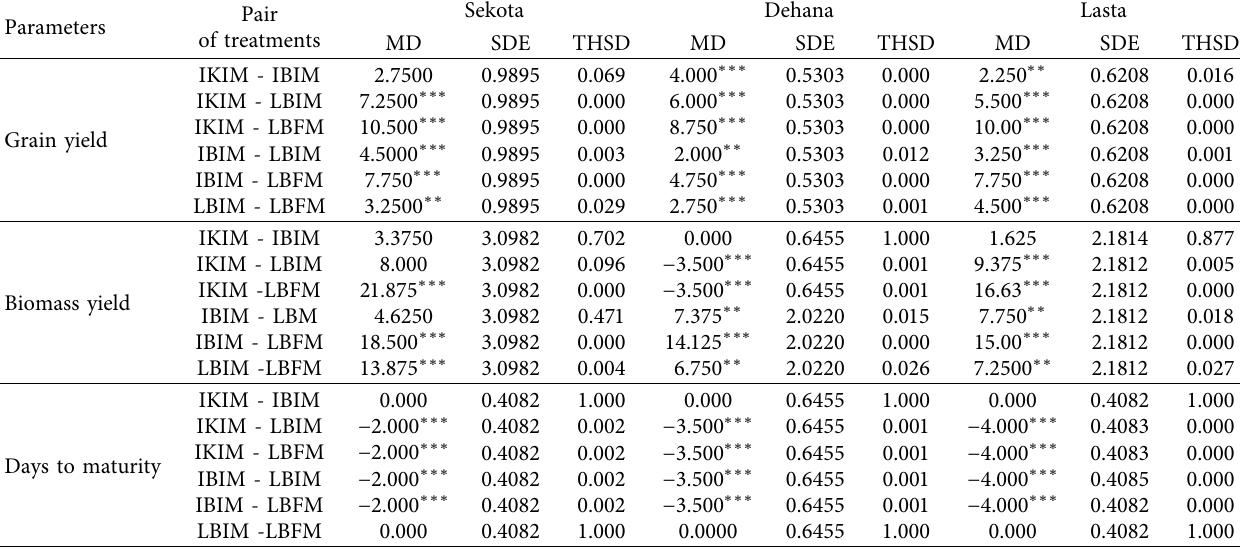
Table 3: Tukey (HSD) test following one-way ANOVA to identify signifcantly consistent treatment across districts. Sekota Dehana Pair Parameters of treatments IKIM - IBIM IKIM - LBIM Grain yield